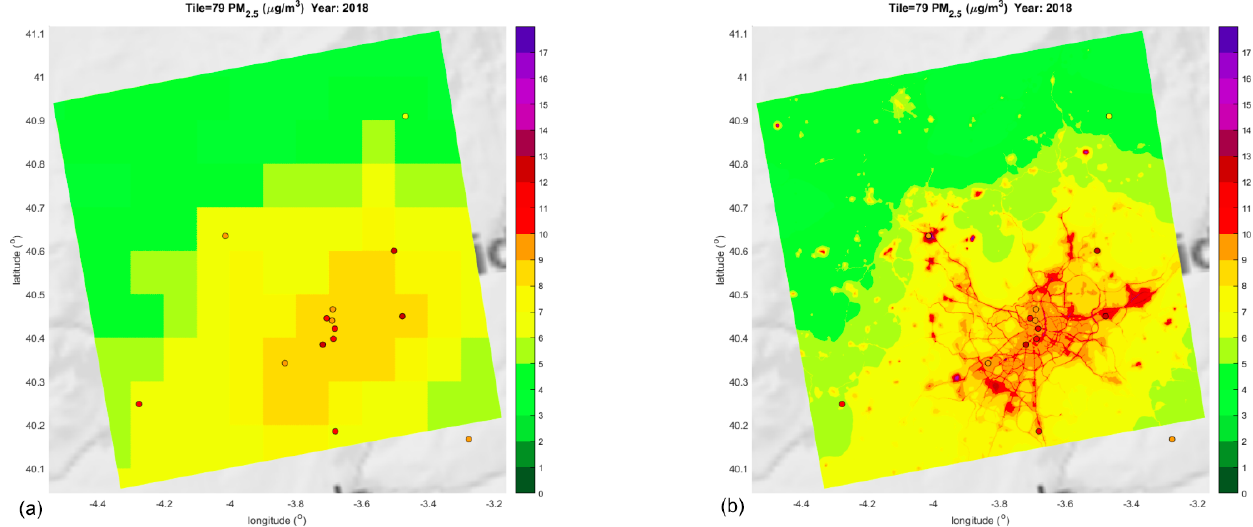
Figure 6. Calculated PM 2 . 5 concentrations in the 100km tile (no. 79) for 2018, which is part of the all European calculation at 100m resolution. (a) The EMEP model calculation at 0.1 ◦ and (b) the uEMEP calculation at 100m resolution. The city in this tile is Madrid. AIRBASE stations are shown as circles.